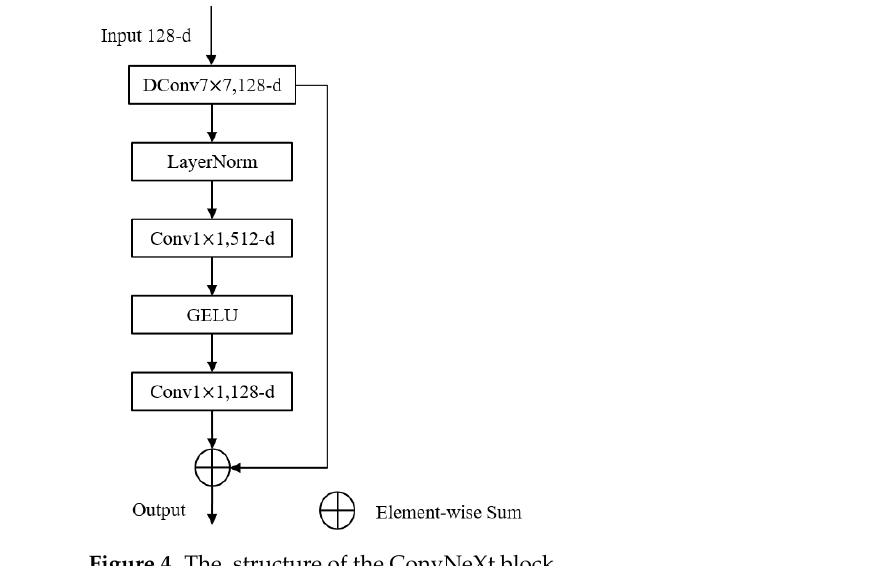
Figure 4. The structure of the ConvNeXt